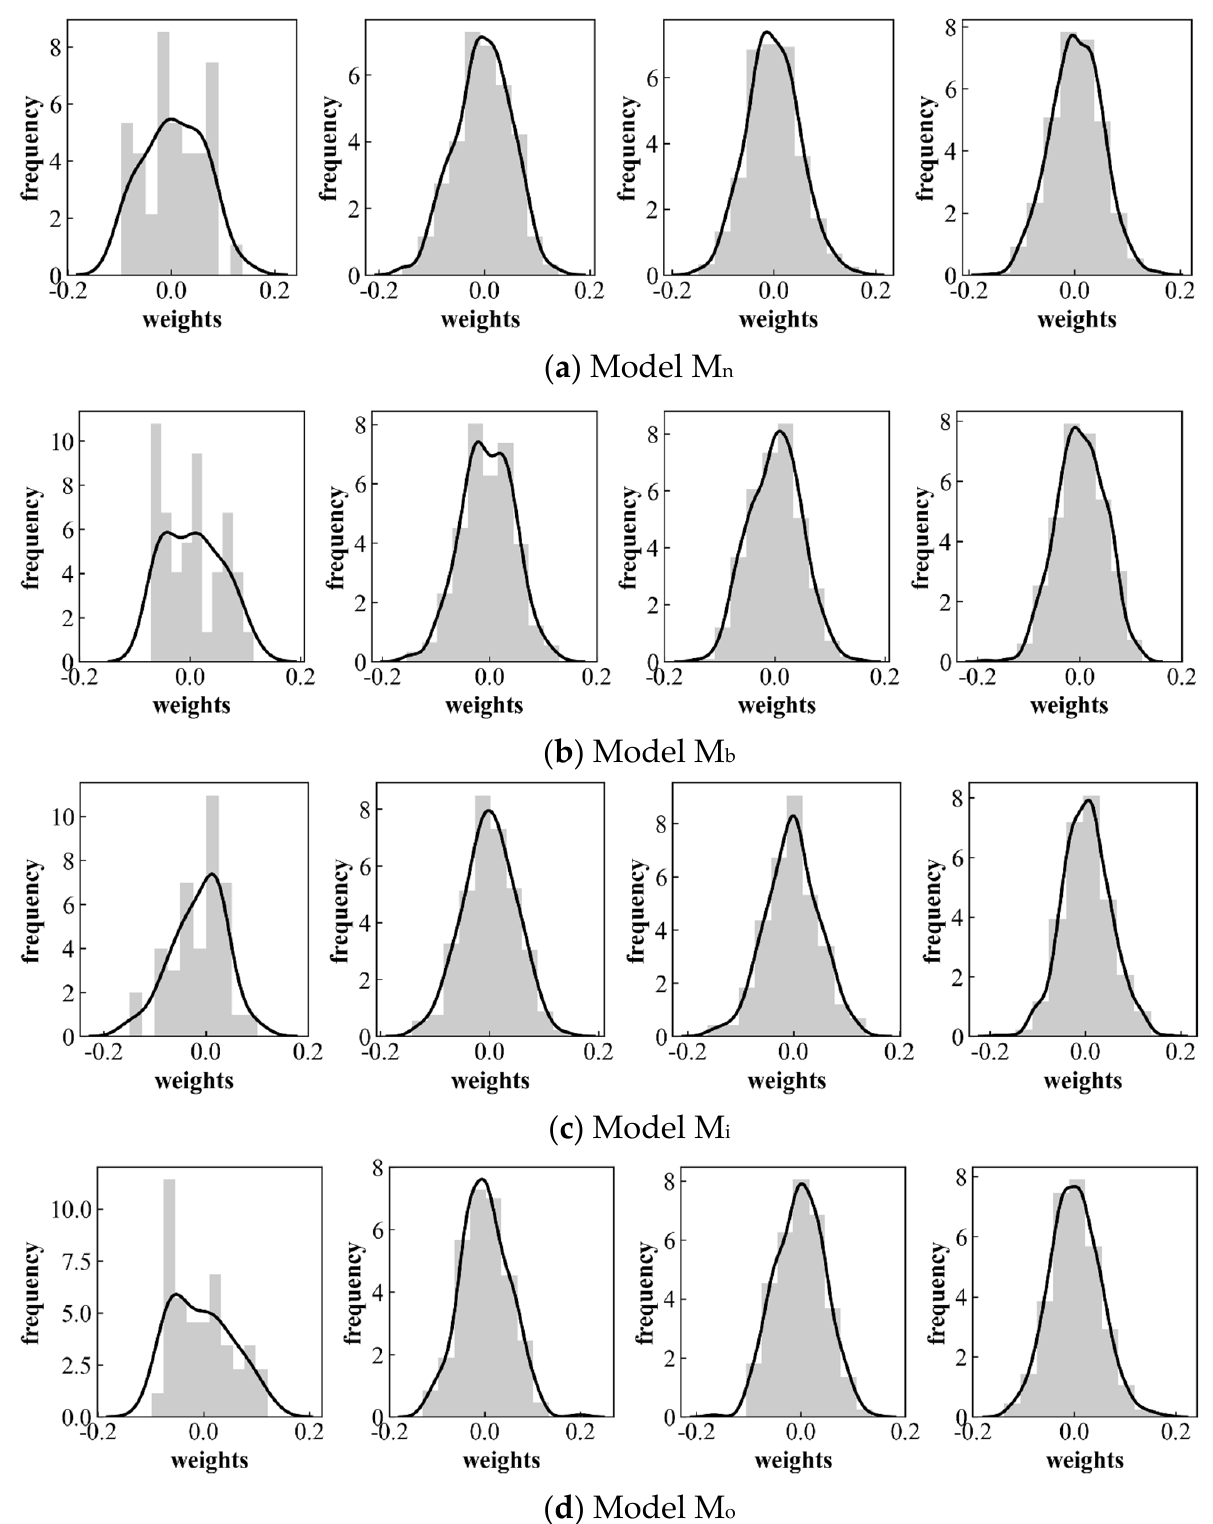
Figure 8. Weight distribution of the local fault diagnosis models.